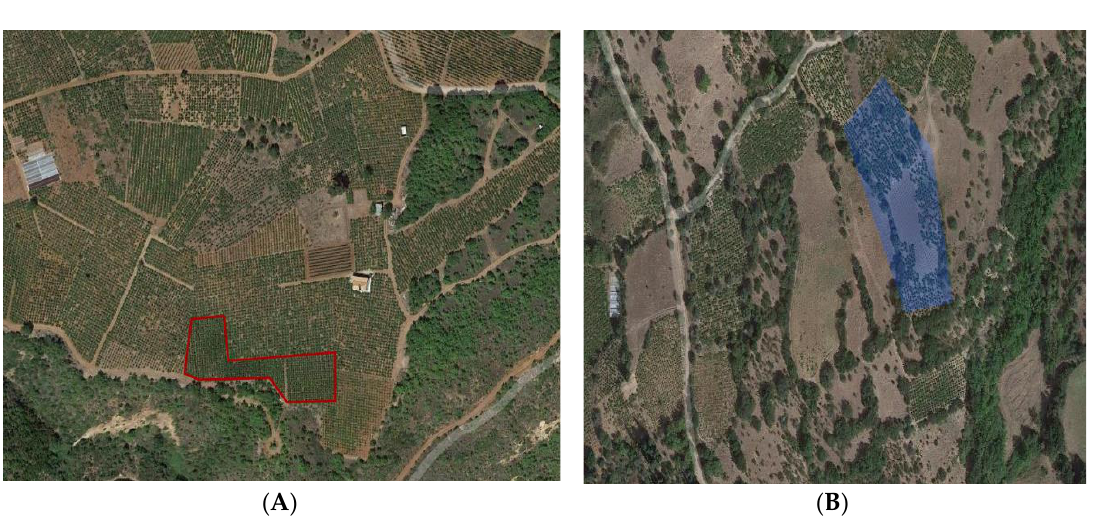
Figure 1. Vineyards in the prefecture of Achaia were the soil samples collected ( A ) Koutsoura (39°1 3′ 01 ″ Β , 23°4 5′ 84 ″ Α ) and ( B ) Petsakoi (38°2 5′ 46.8 ″ Β , 22°1 0′ 26.5 ″ Α ).